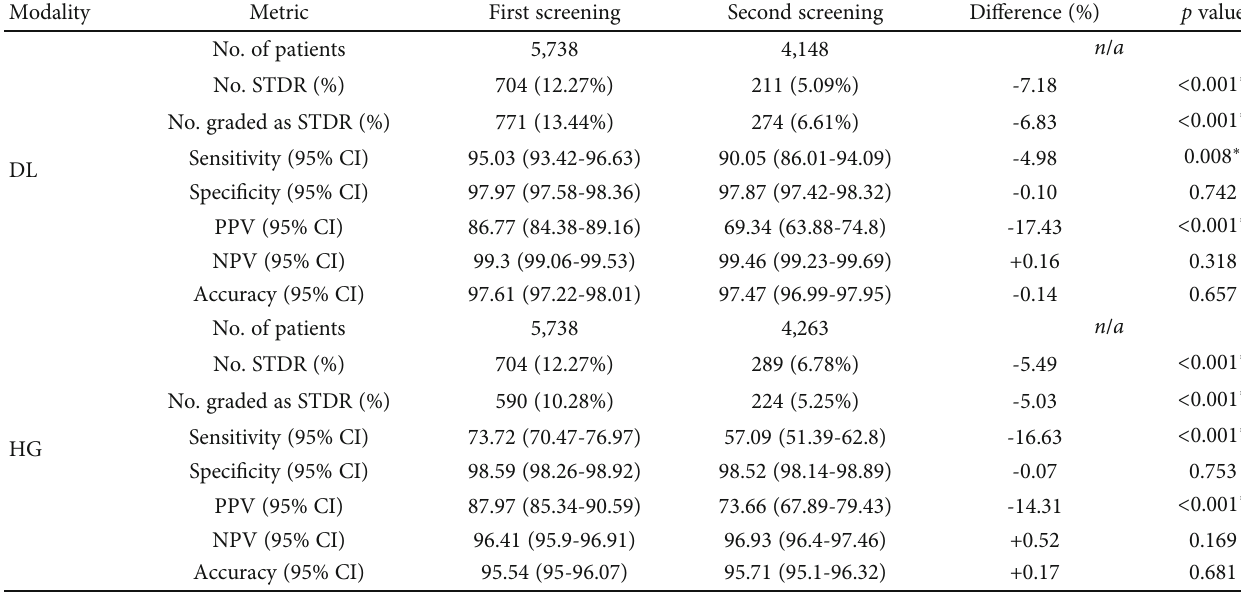
Table 2: The number of patients with sight-threatening diabetic retinopathy including the screening outcomes in the fi rst and second screening determined by each modality.